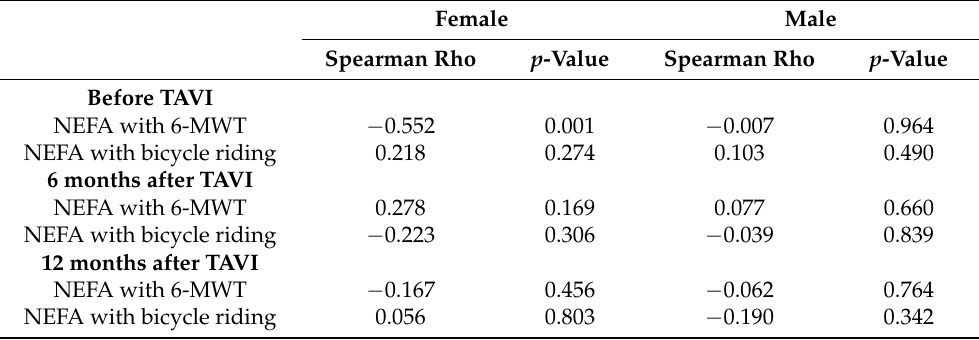
Figure 4. Association between NEFA concentration before TAVI and distance in six-minute walk test. Separated by sex, there was no correlation of NEFA concentrations at 6 and 12 months with 6-MWT or bicycle riding at 6 and 12 months (Table 3). Table 3. Sex-specific correlation of NEFA concentrations before and after TAVI with physical per- formance over 12 months.